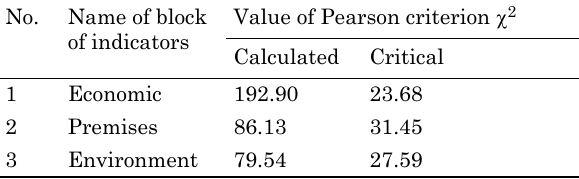
Table 5. Results of the verification of the compatibility with expert assessments of the importance of the office lease indicators